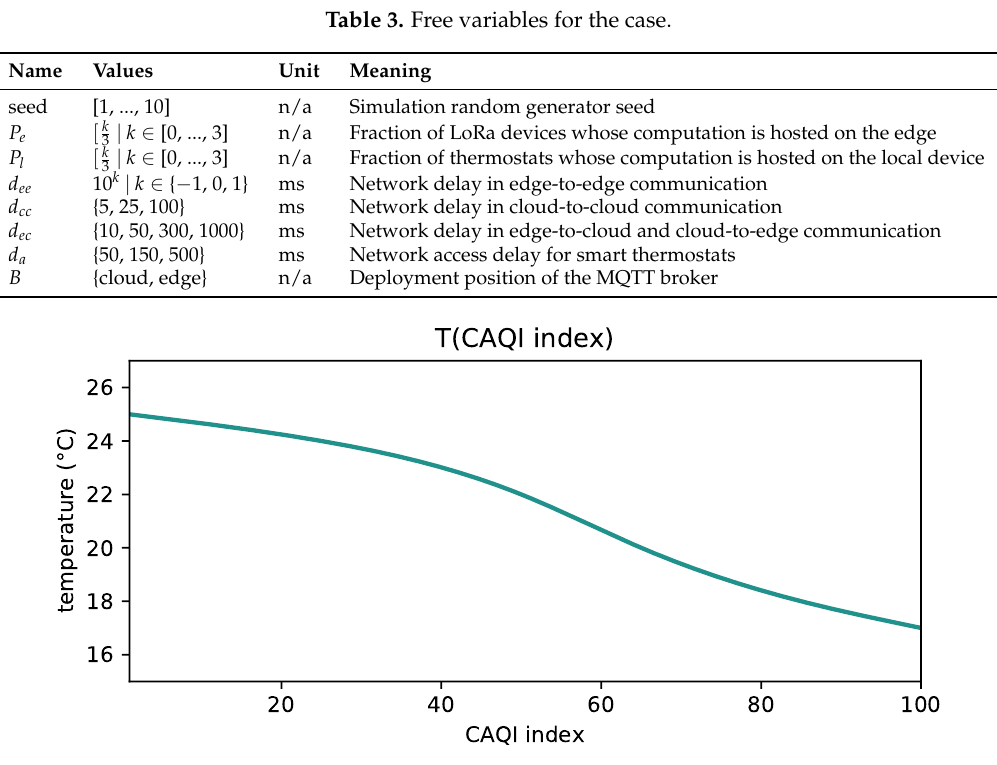
Figure 7. Function used in the case study to set the maximum allowed temperature setpoint based on the current estimation of the CAQI index (a metric of air